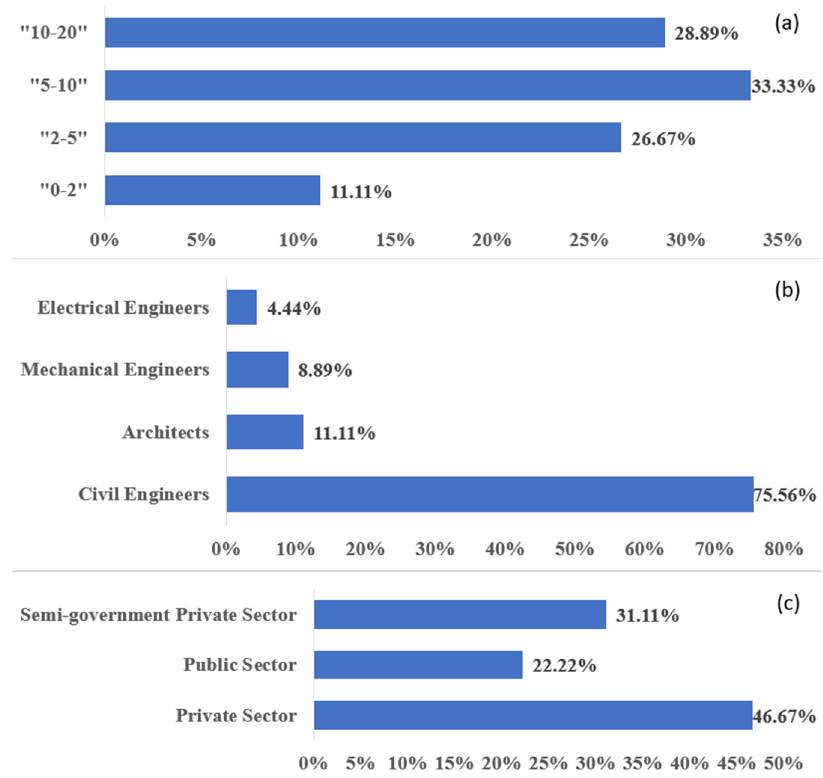
Figure 2. Demographic profile of respondents. ( a ) Years of experience; ( b ) Engineering disciplines of participants, and ( c ) Involvement in construction sectors.